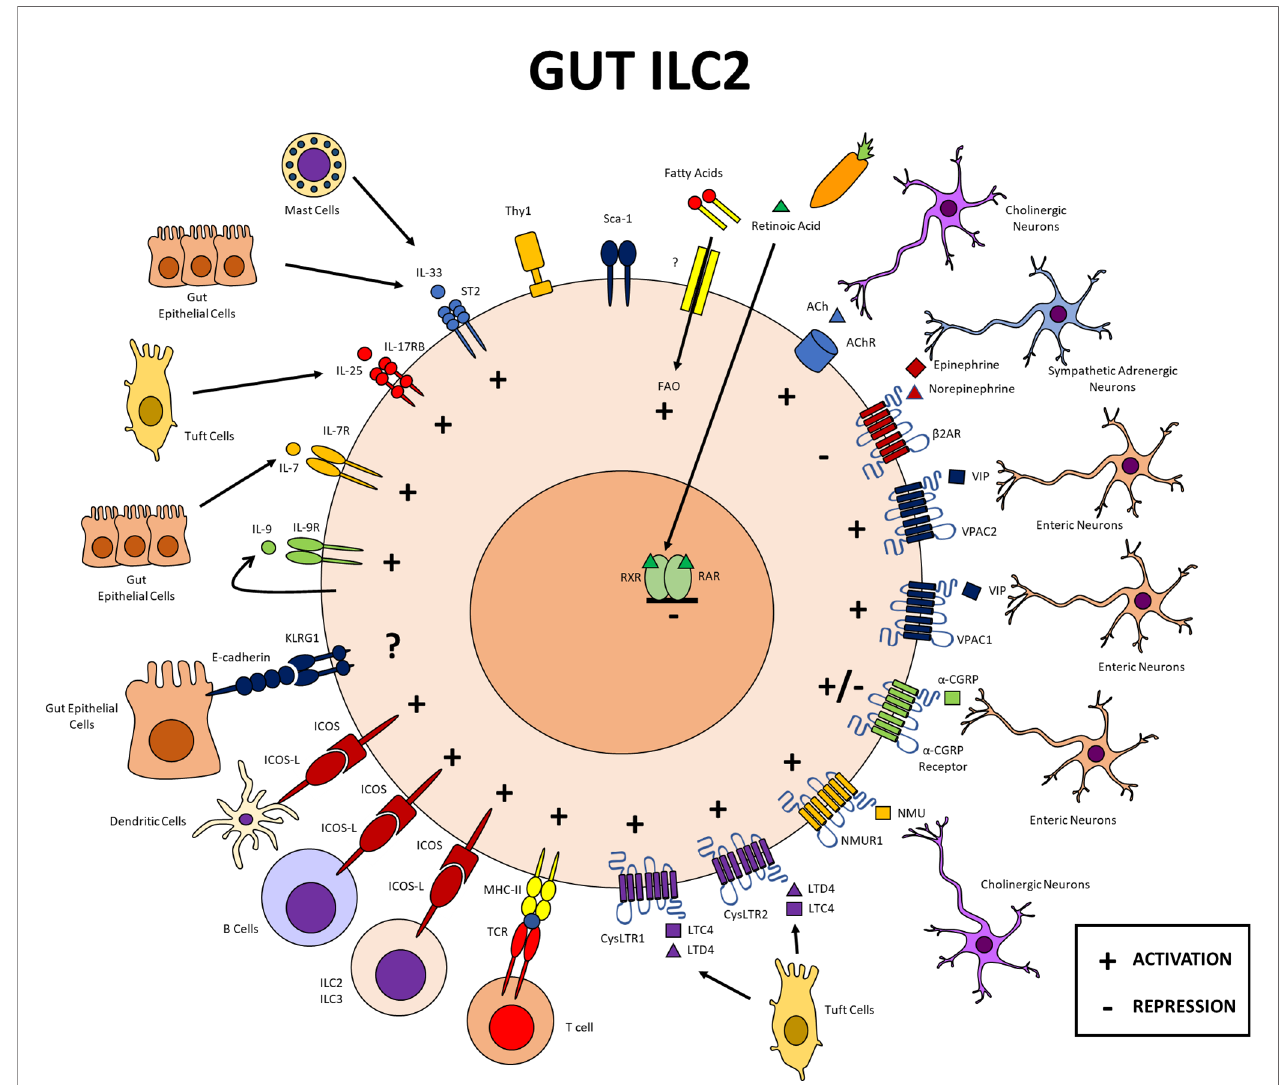
FIGURE 2 | Gut ILC2s. Expression of different markers in intestinal ILC2s and cellular interactions within this tissue. In the gut, ILC2s interact with other immune cells, neurons, epithelial cells, among other populations. All cytokine, leukotriene, and neuropeptide receptors mentioned in this review, except the b 2AR, provide signals that activate ILC2s in the gut. CGRP both positively and negatively regulates these cells. In the gut, expression of MHCII, ICOS and its ligand favors the function of ILC2s. The function of ILC2s in this tissue depends on fatty acid oxidation, while retinoic acid inhibits ILC2s. PG, prostaglandin; LT, leukotriene; NMU, neuromedin U; CGRP, calcitonin gene related peptide; VIP, vasoactive intestinal peptide; RAR, retinoid acid receptor; RXR, retinoid X receptor; fatty acids